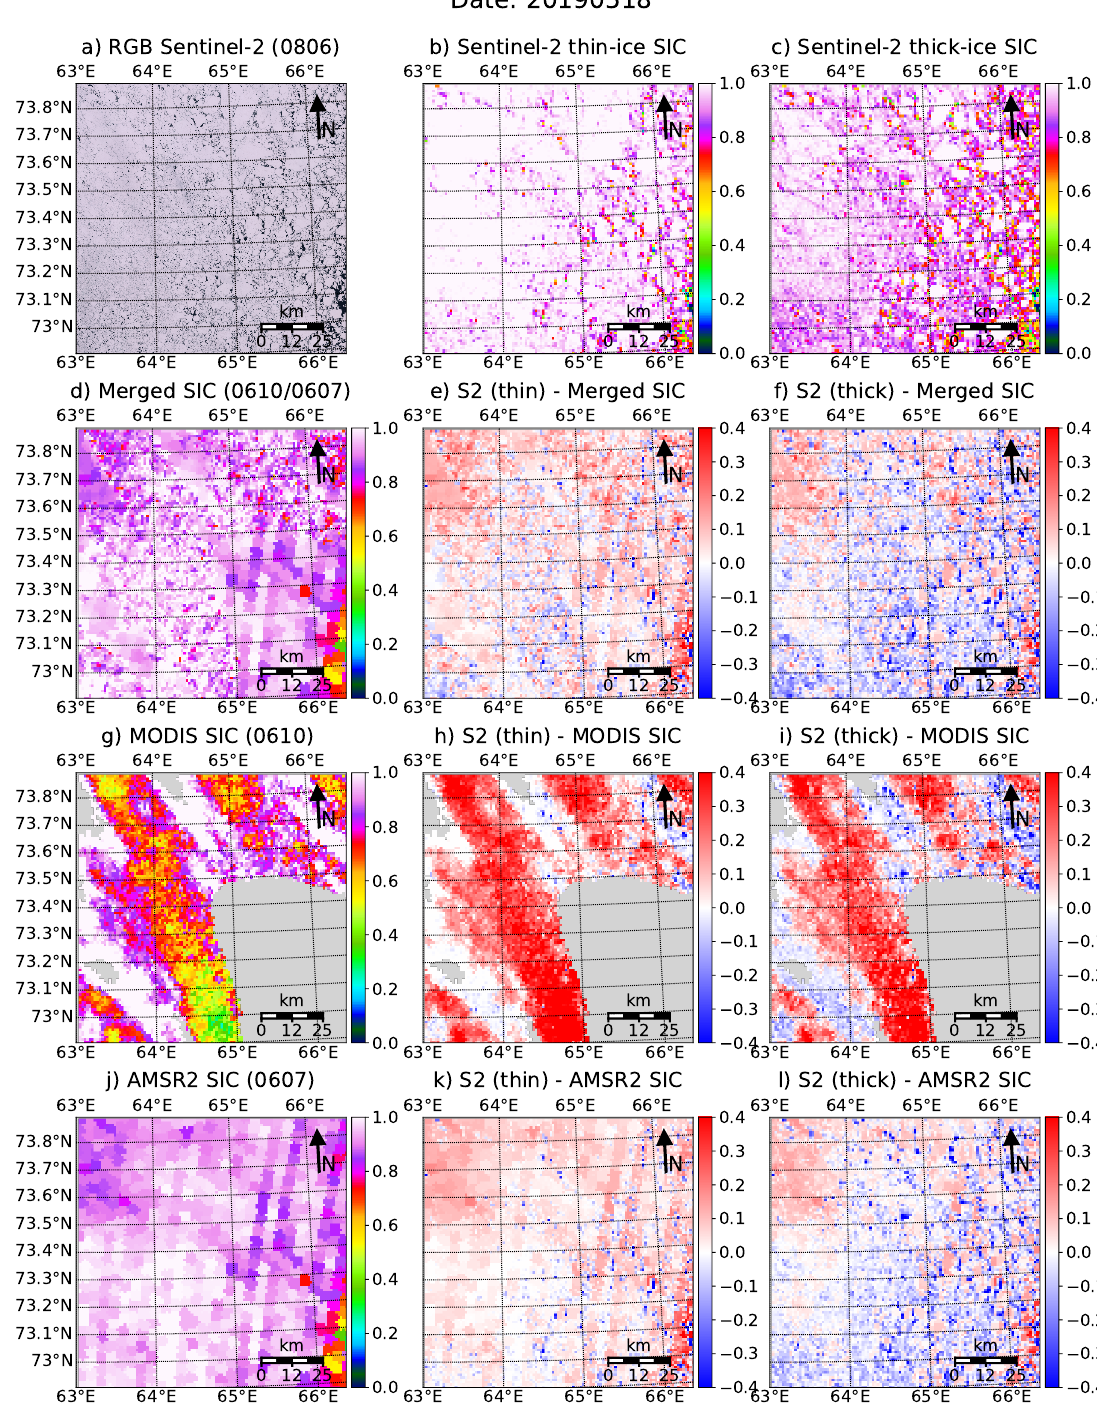
Figure 9. Sentinel-2 scene in the Kara Sea on 18 May 2019 and the corresponding SIC maps. ( a ) Sentinel-2 RGB image. Sentinel-2 SIC with thin ice considered as ice ( b ) and water ( c ). ( d – f ) The merged SIC and their difference to the thin- and thick ice Sentinel-2 SIC. Panels ( g – i , j – l ) show the same for MODIS and AMSR2 SIC, respectively. The acquisition times for the single scenes in UTC are given in brackets in the titles of the maps in the left